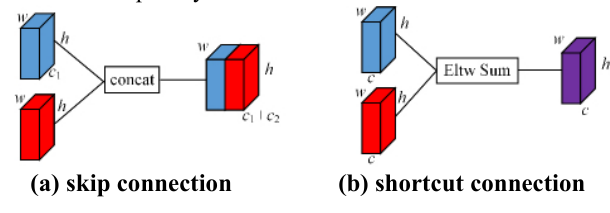
Figure 1. Two connection